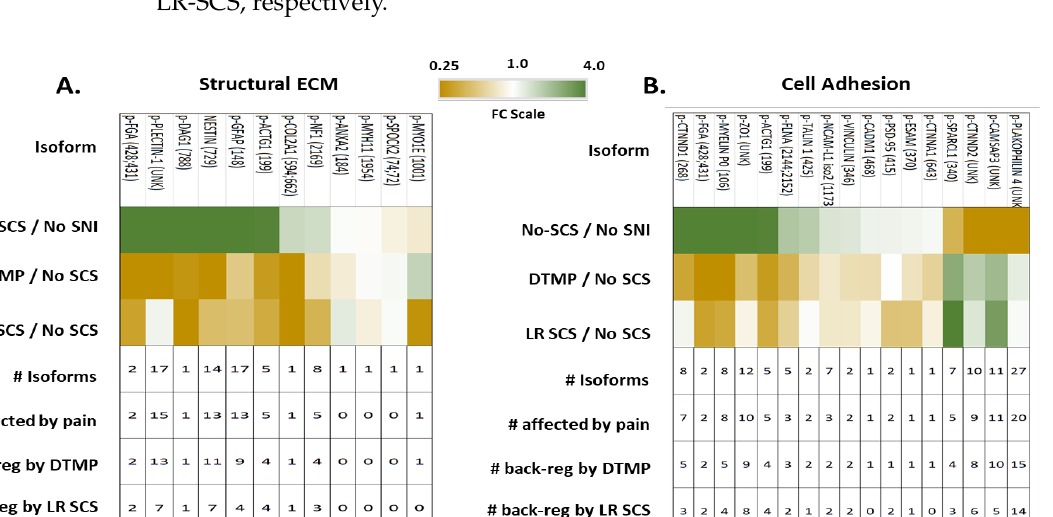
total of 111 isoforms, of which 92 (83%) were affected by the pain model, with 75 (82%) being back-regulated by DTMP and 59 (64%) by LR-SCS. Figure 4B (Table S5) summarizes the findings and presents a heat map with the 17 isoforms most affected by the pain model. Neither neurexins nor neuroligins were identified in the phosphoproteomic data- base. Of the cell adhesion molecules (CAMs), seven p-NCAM isoforms were observed, with three of them affected by the pain model and two of them back-regulated by both DTMP and LR-SCS. CADM1 had one phosphorylated isoform which was affected by the pain model and back-regulated by DTMP but not LR-SCS. Of the three catenin proteins found in the proteomic data, all three yielded nineteen phosphorylated isoforms, of which seventeen were affected by the pain model, and DTMP was shown to back-regulate ex- pression levels of fifteen, whereas LR-SCS back-regulated nine. Of the other proteins men- tioned in the proteomics section, only vinculin (VCL) and FLNA showed to be phosphor- ylated. VCL had two isoforms that were affected by the pain model and back-regulated by both DTMP and LR-SCS. The filamin protein, FLNA, had five isoforms, with three af- fected by the pain model, and all tree back-regulated by DTMP, whereas two were back- regulated by LR-SCS. The 70 cell junction proteins identified were shown to have 790 p-isoforms with 664 (84%) affected by the pain model. DTMP back-regulated phosphorylation levels of 509 of these (77%) and LR-SCS back-regulated 390 (59%). Figure 5 (Table S6) summarizes the